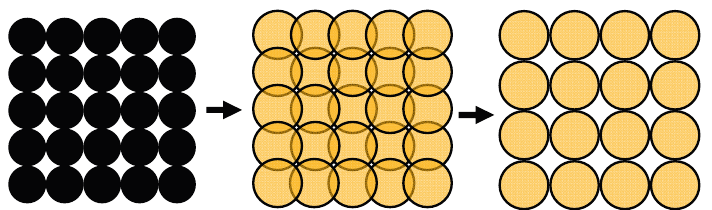
Figure 8. The theoretical full load with nickel grains on the left side. During sulfidation, the circular areas increase (in the middle) and a smaller number of spherical grains are needed for the theoretical full load (on the right